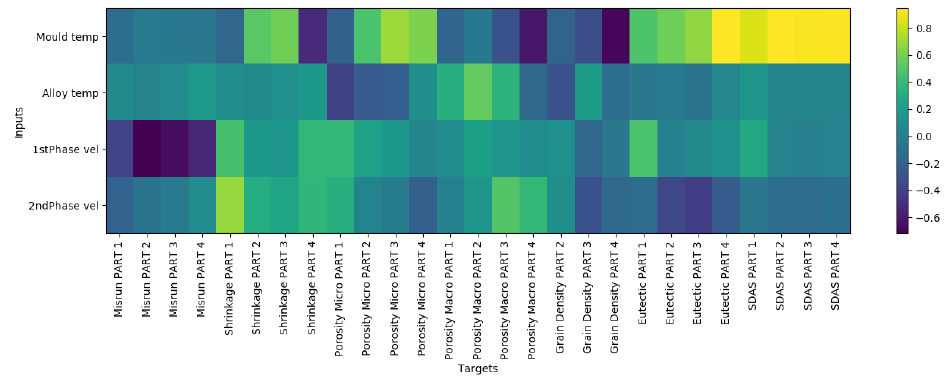
Figure 12. Pearson correlation between inputs and targets. The scale of the image indicates the correlation between the variables (0–1).